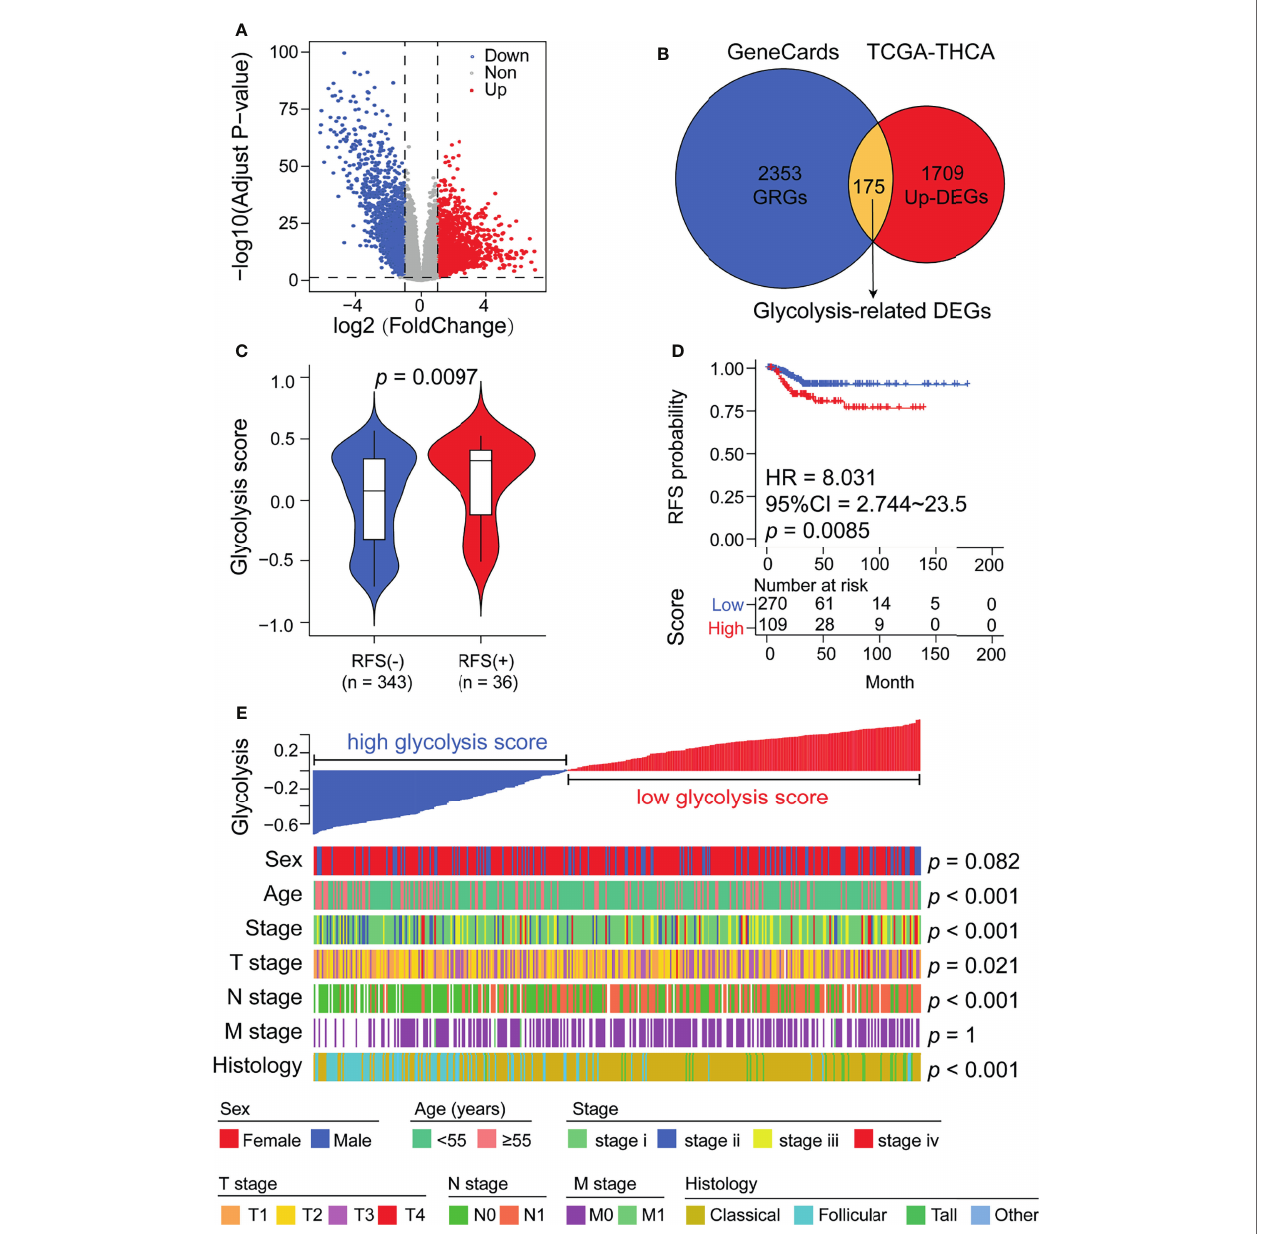
FIGURE 2 | Glycolysis scores are associated with thyroid cancer recurrence and various clinicopathological features. (A) Volcano plot showing DEGs between normal thyroid and cancer samples in the TCGA cohort. (B) Venn diagram demonstrating the screening methods for 175 candidate glycolysis-related DEGs. (C) Glycolysis scores were signi fi cantly elevated in patients who relapsed after surgery. (D) Kaplan – Meier analysis showing that patients with higher glycolysis scores exhibited worse RFS. (E) A heatmap depicting the correlations between glycolysis scores and clinicopathological